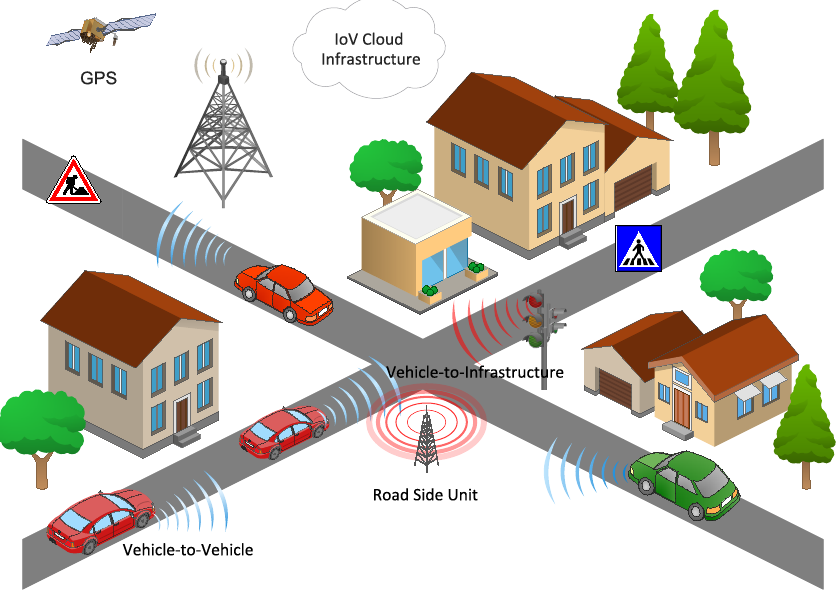
Figure 3. Schematic of ITS